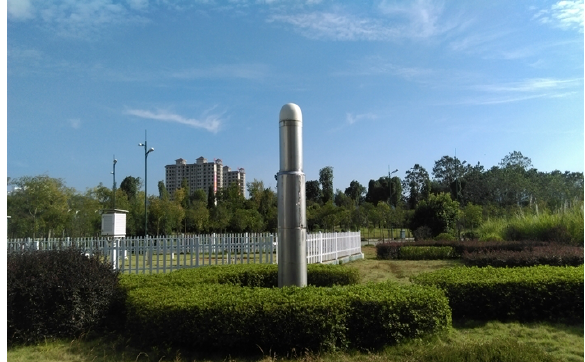
Figure 1. Continuously operating reference